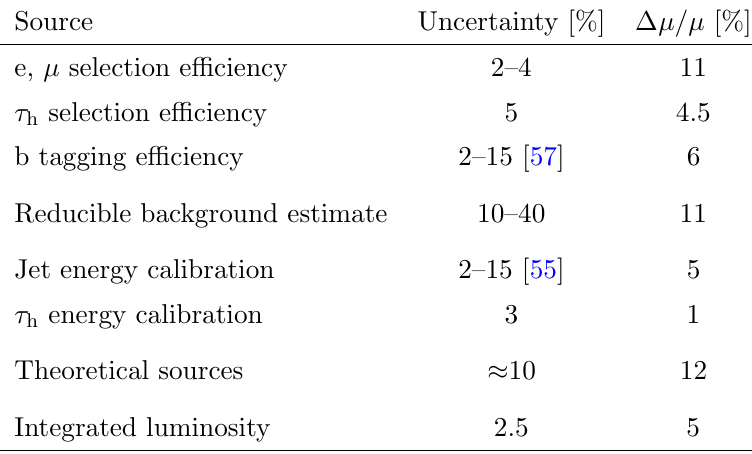
Table 4 . Summary of the main sources of systematic uncertainty and their impact on the combined measured ttH signal rate (cid:22) . (cid:1) (cid:22)=(cid:22) corresponds to the relative shift in signal strength obtained from varying the systematic source within its associated